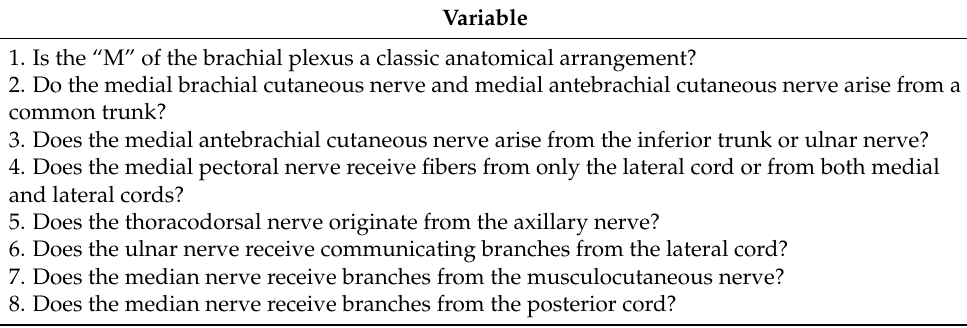
Table 1. Variables on clinically relevant brachial plexus branching variations collected in this